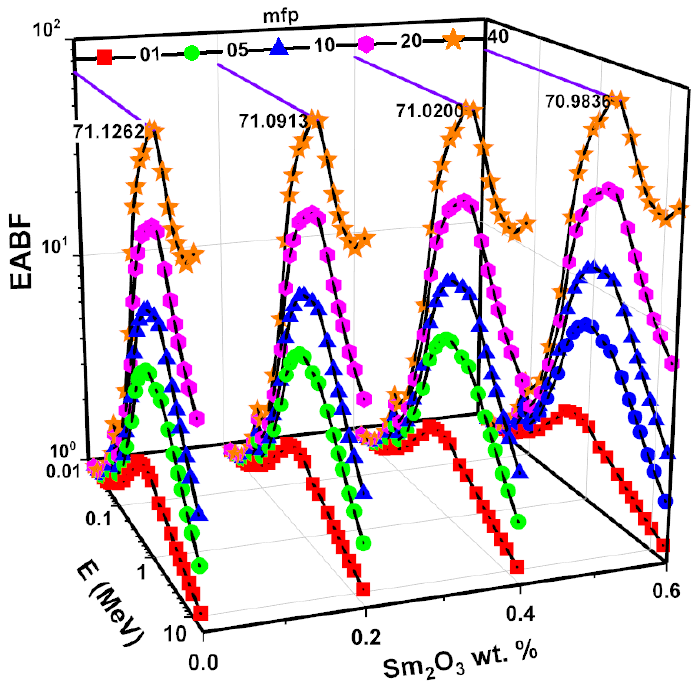
Figure 16. EABF for samples as a function of energy at 1, 5, 10, 20, and 40 mfp.